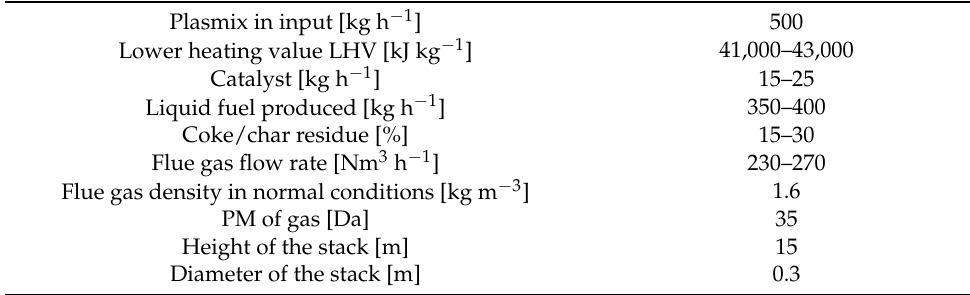
Table 2. Operating conditions of the catalytic pyrolysis plant.